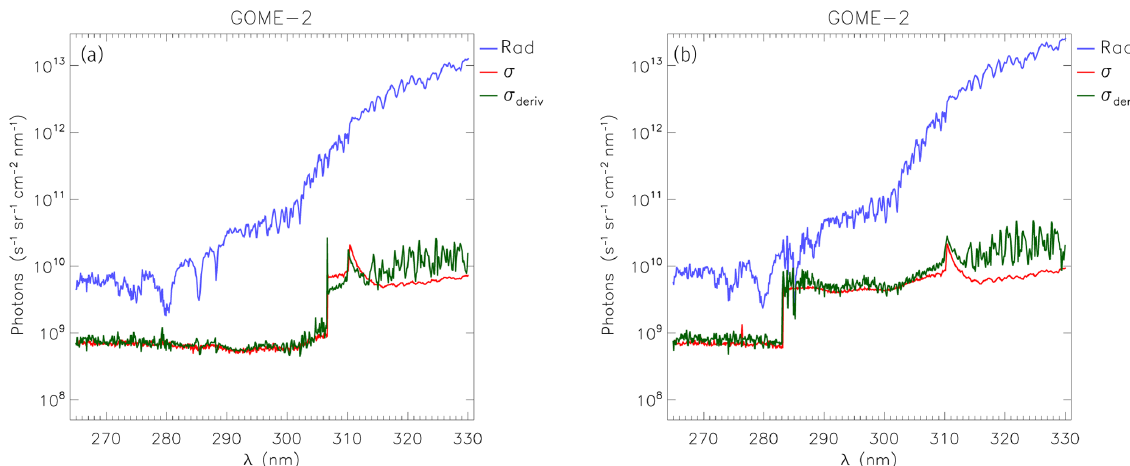
Figure 1. GOME-2 Metop-A radiance spectra calculated by OPERA: before (a) and after (b) the wavelength shift from 307 to 283nm. The blue and red lines are the radiance and uncertainty that are used in OPERA. The green line shows the fitted standard deviations of the relative difference (see Eq. 14) multiplied by the radiance.